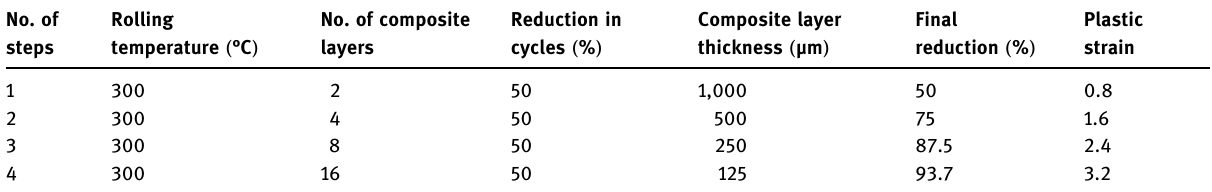
Table 1: ARB process steps for fabrication of Al/alumina composites No.